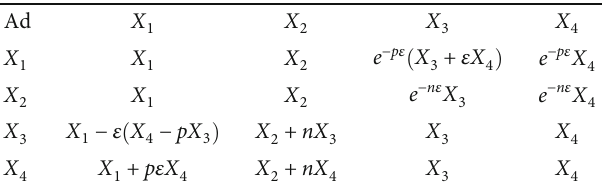
1 , X 2 , X 3 , and X 4